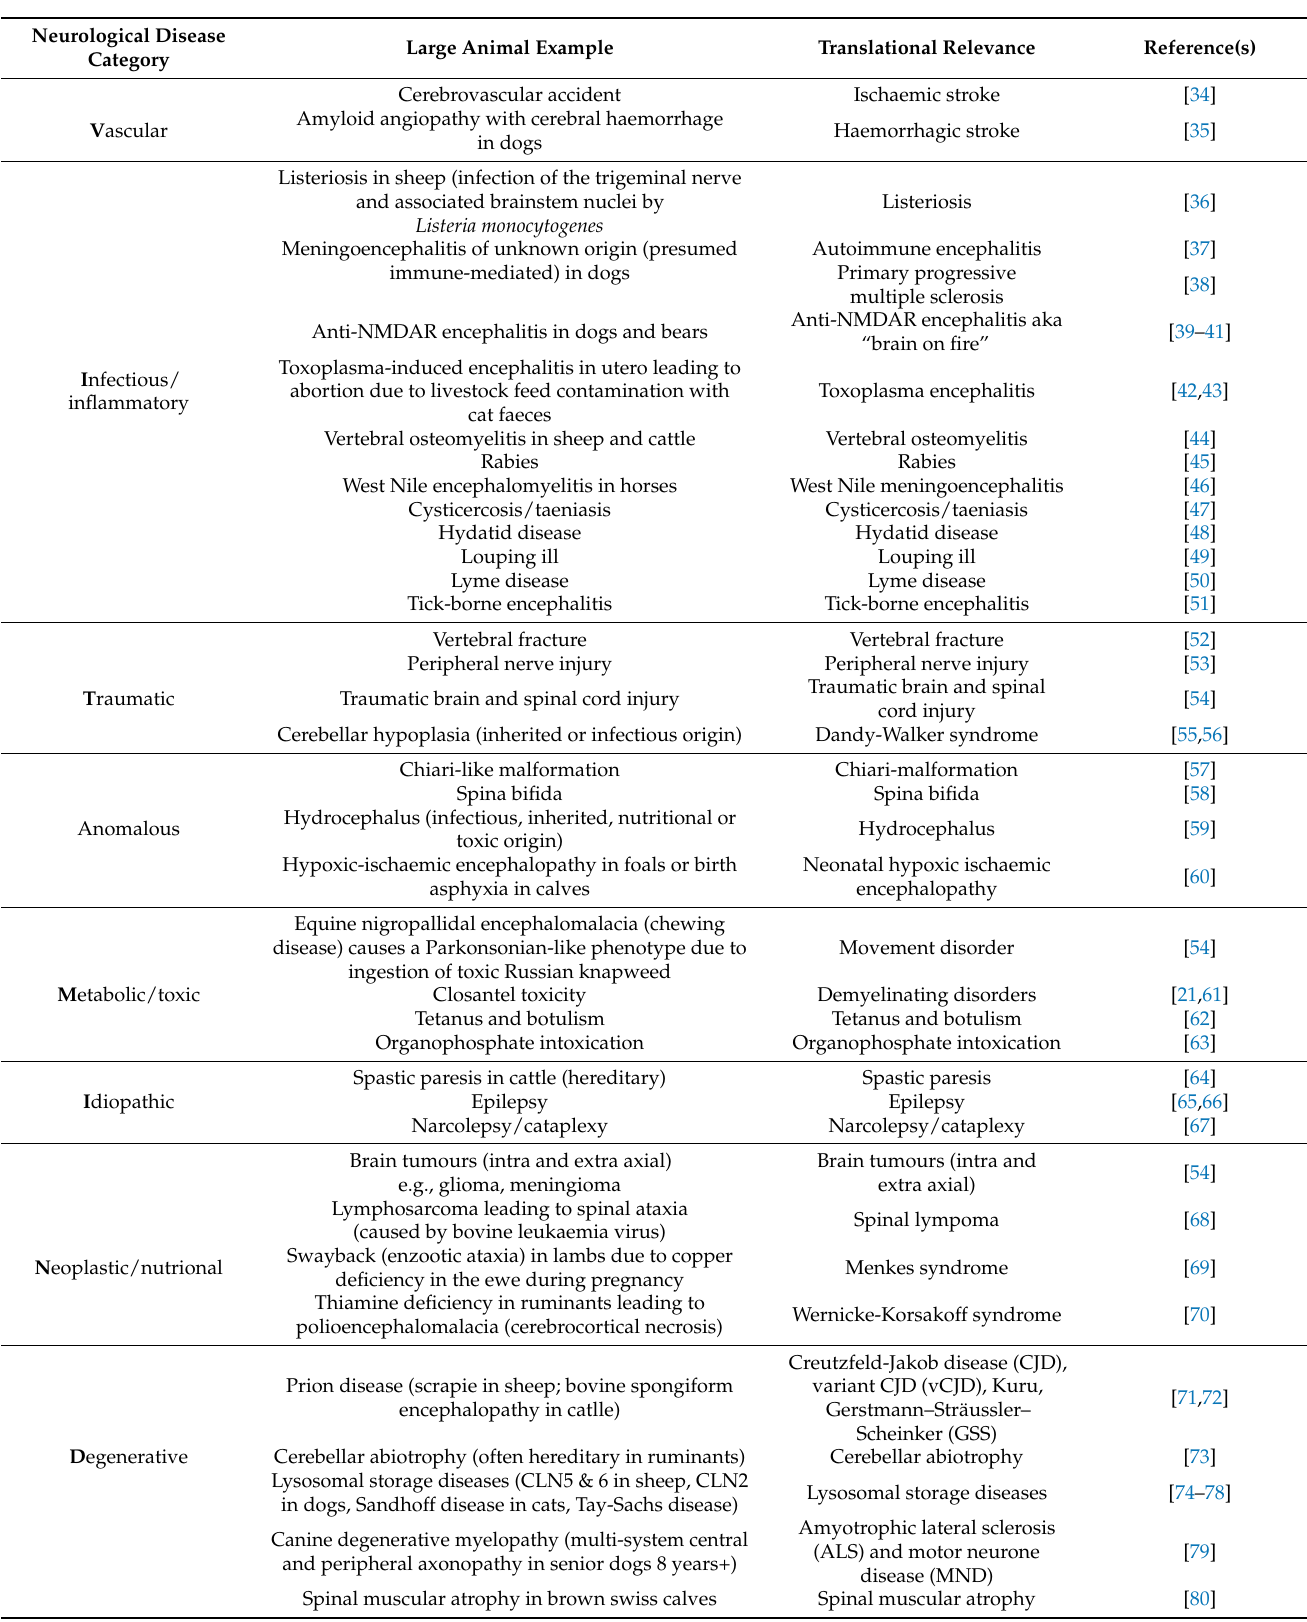
Table 1. Classification of neurological conditions using VITAMIN D